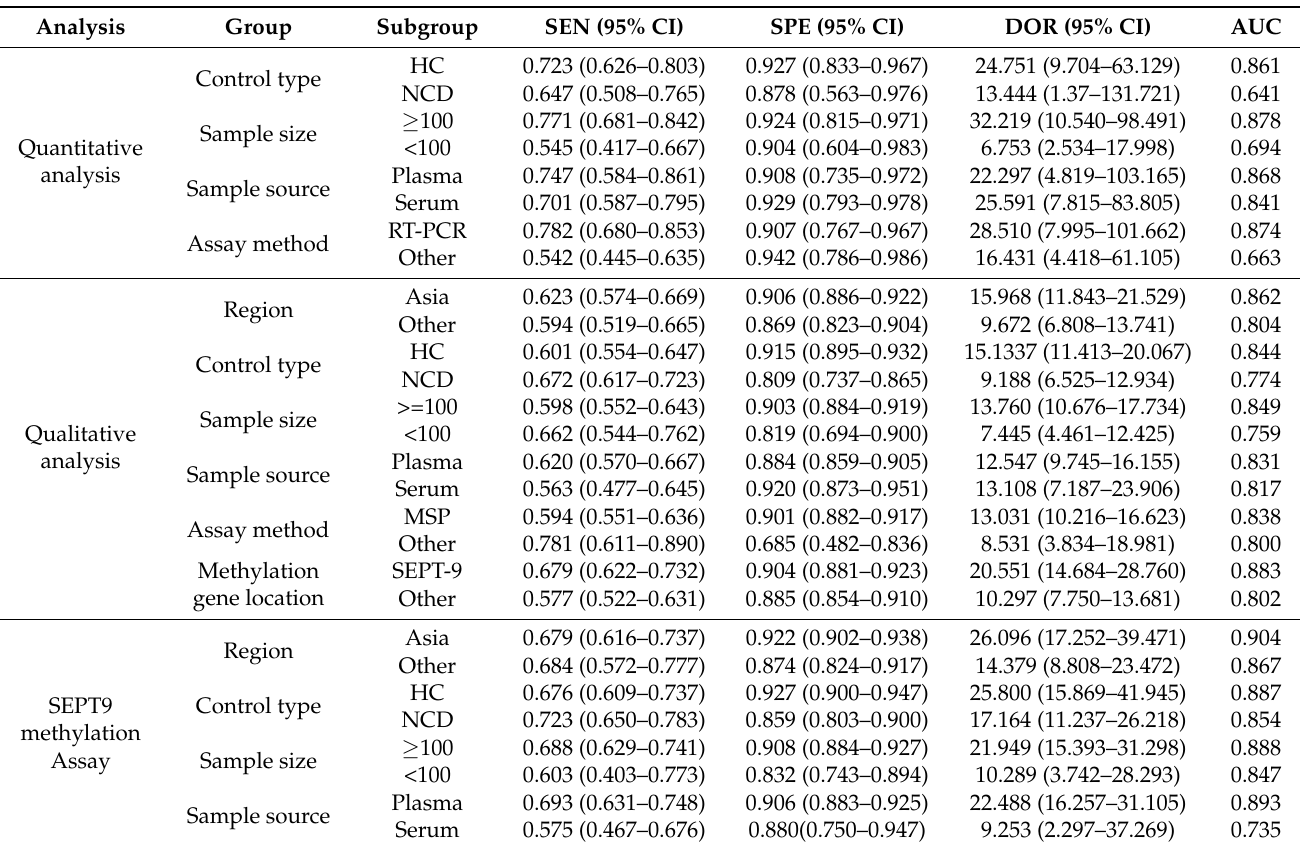
Table 2. Subgroup analysis of diagnostic performance of ctDNA assay for CRC.